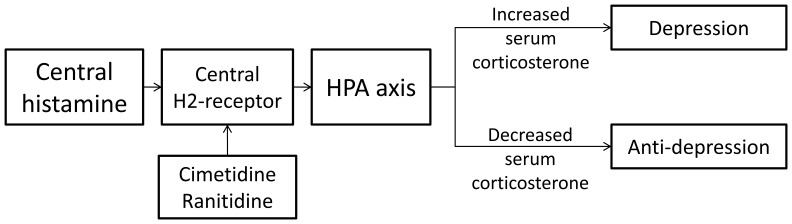
Diagram showing the depressant action of H2 receptor antagonists.